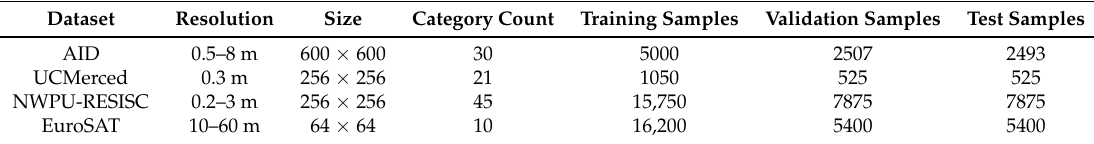
Table 2. General information of